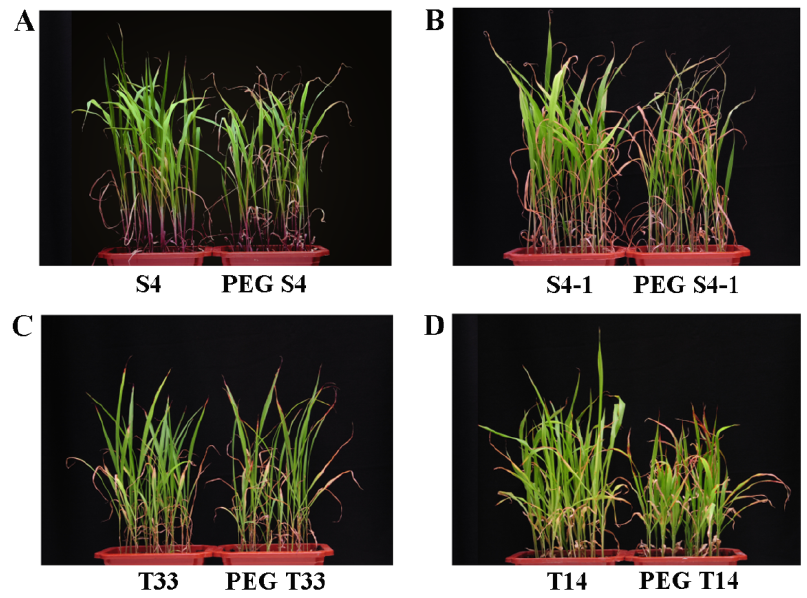
Figure 2. Phenotypic characteristics of the four sorghums varieties after 28 days of PEG treatment. Phenotypes of the sorghum S4/PEG S4 ( A ), S4-1/PEG S4-1 ( B ), T33/PEGT33 ( C ), and T14/PEG T14 ( D ) at the seedling stage. The left is the control group (S4, S4-1, T33, and T14), and the right is the PEG treatment group (PEG S4, PEG S4-1, PEGT33, and PEG T14).